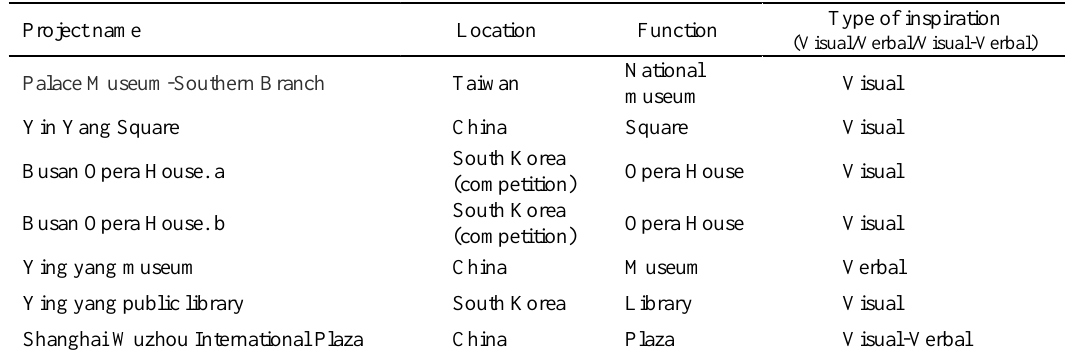
Table 1: Types of inspiration